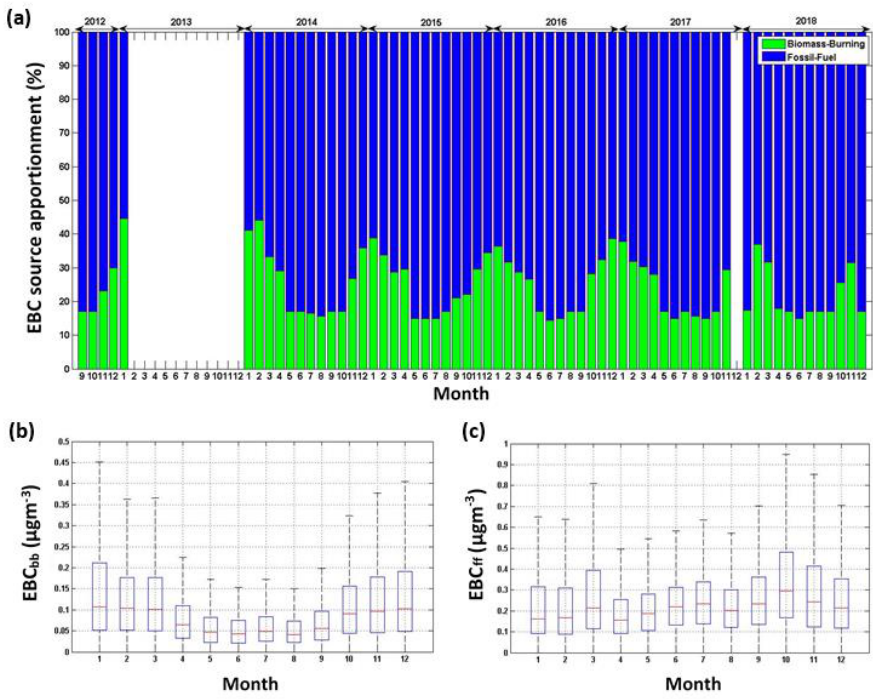
Figure 5. ( a ) Average relative contribution (%) of the two EBC sources over the entire measurement period. ( b , c ): Seasonal variations of the two EBC sources in µ g m − 3 , Biomass Burning (lower left panel) and Fossil Fuel (lower right panel). Red lines represent the median value, bottom and top sides of the boxes symbolize the 25th and 75th percentile, respectively. The length of the whiskers represents 1.5 × interquartile range which includes 99.3% of the data.